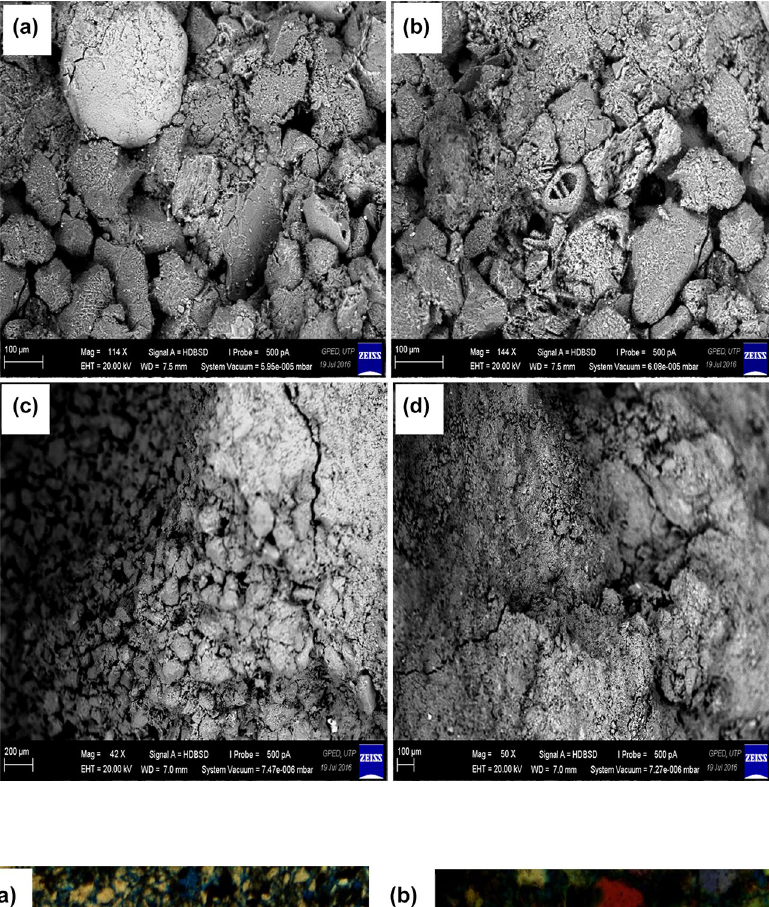
Fig. 10 Petrography of rock fabric variations. ( a ) A lamina boundary of medium-fine grained, ( b ) a XPL of pore- filling iron oxide, rectorite and siderite matrix, ( c ) a wide matrix-fracture pore, ( d ) an extensive matrix-fracture pore in MFFGS (WK`12T4) lithofacies sandstone at depth 1343.8